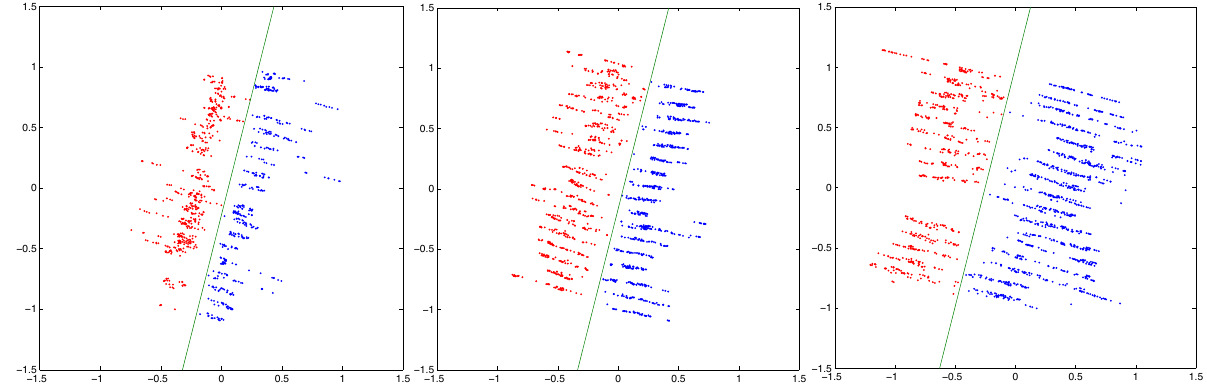
Figure 21. Top view of the point clouds for the different row sections, low vigor ( left ); medium vigor ( center ); and high vigor ( right ). The gap on the left side in the third section was due to some problem in the data acquisition. Local coordinates were used to plot the points (m).